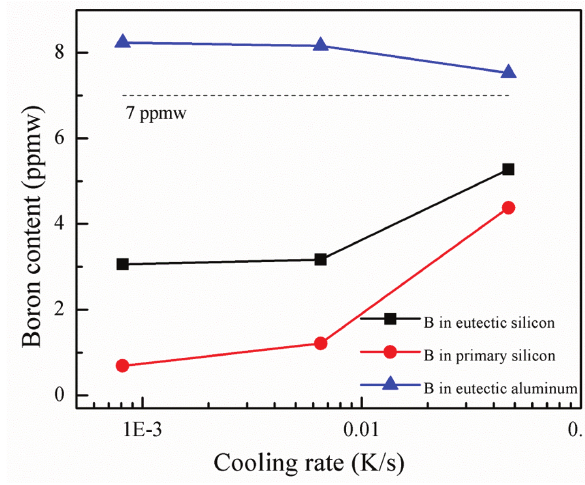
Figure 5: The boron contents in experiment series